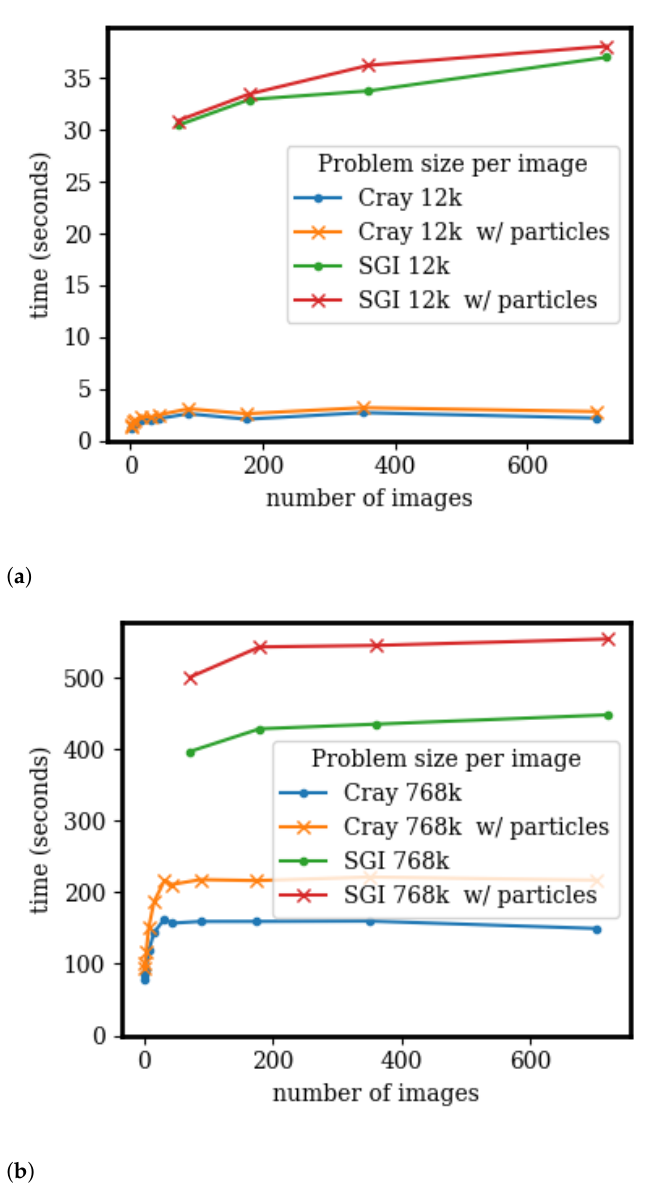
Figure 16. ( a ) Twelve-thousand grid cells per process; ( b ) 768 k grid cells per